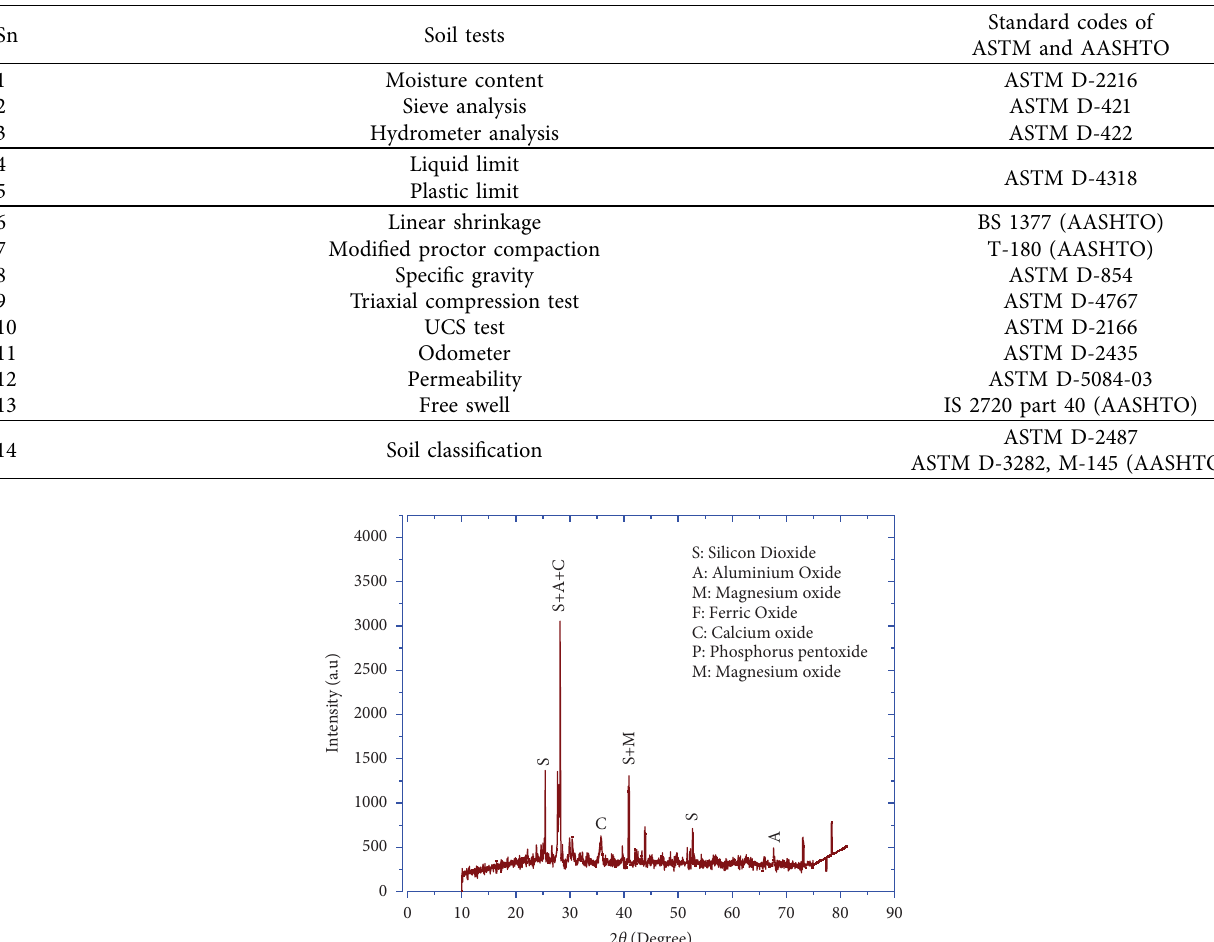
Table 2: Te standards used to experimentally characterize the materials.